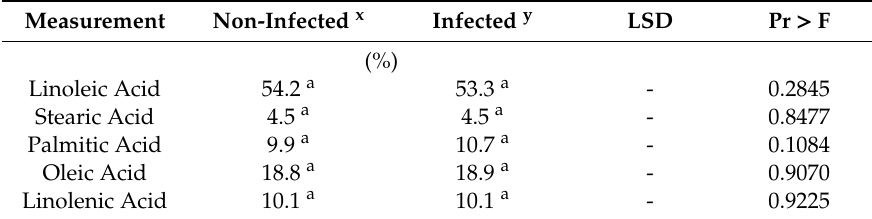
Table 5. The comparison of non-symptomatic compared to infected soybean seed as it influenced seed fatty acids content. The field experiment was conducted in 2019 at the Delta Research and Extension Center in Stoneville,